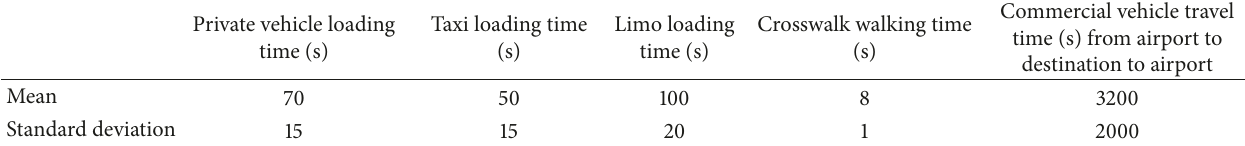
Table 3: Variable inputs for base